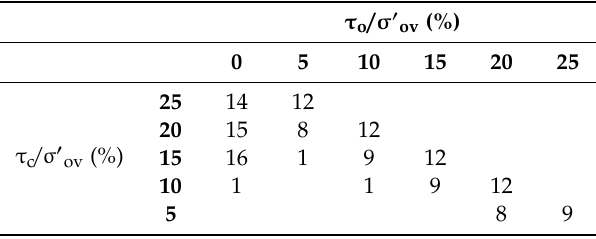
Table 1. Number of tests for each combinations of stresses with which the cyclic simple shear tests were